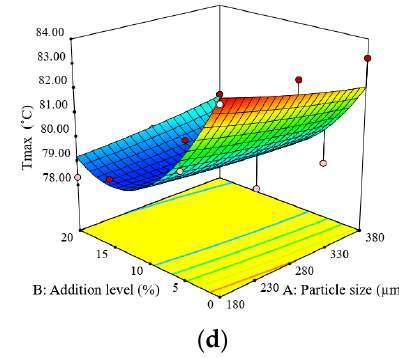
Figure 5. 3D response surface graphic presenting the effect of quinoa flour particle and addition level on: ( a ) storage modulus (G’); ( b ) loss modulus (G ″ ); ( c ) viscosity factor (tan δ ); ( d ) maximum gelatinization temperature (T max ).